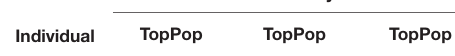
TABLE 3 | Comparison of the NDCG at 10 value and overall model ranking for ContentWise Impressions. Carousel layout Individual TopPop